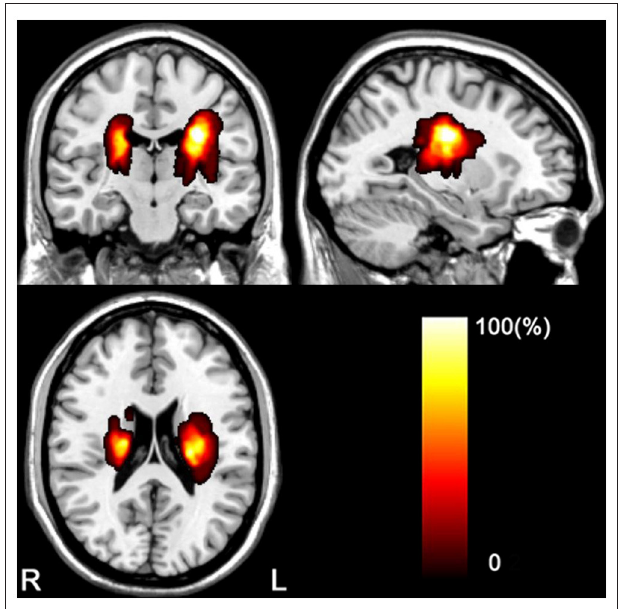
TABLE 1 | Demographic and clinical information of the participants.